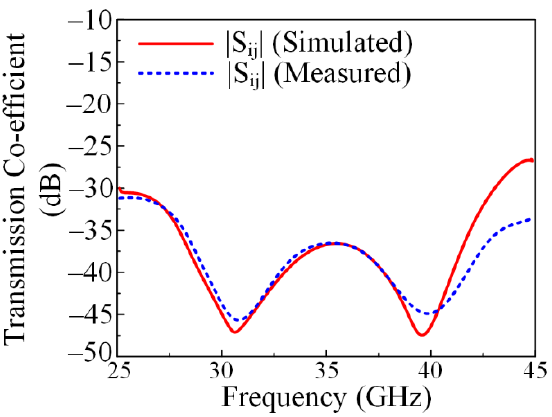
Figure 11. Comparison of measured and simulated transmission coefficients with parasitic ele- ment.